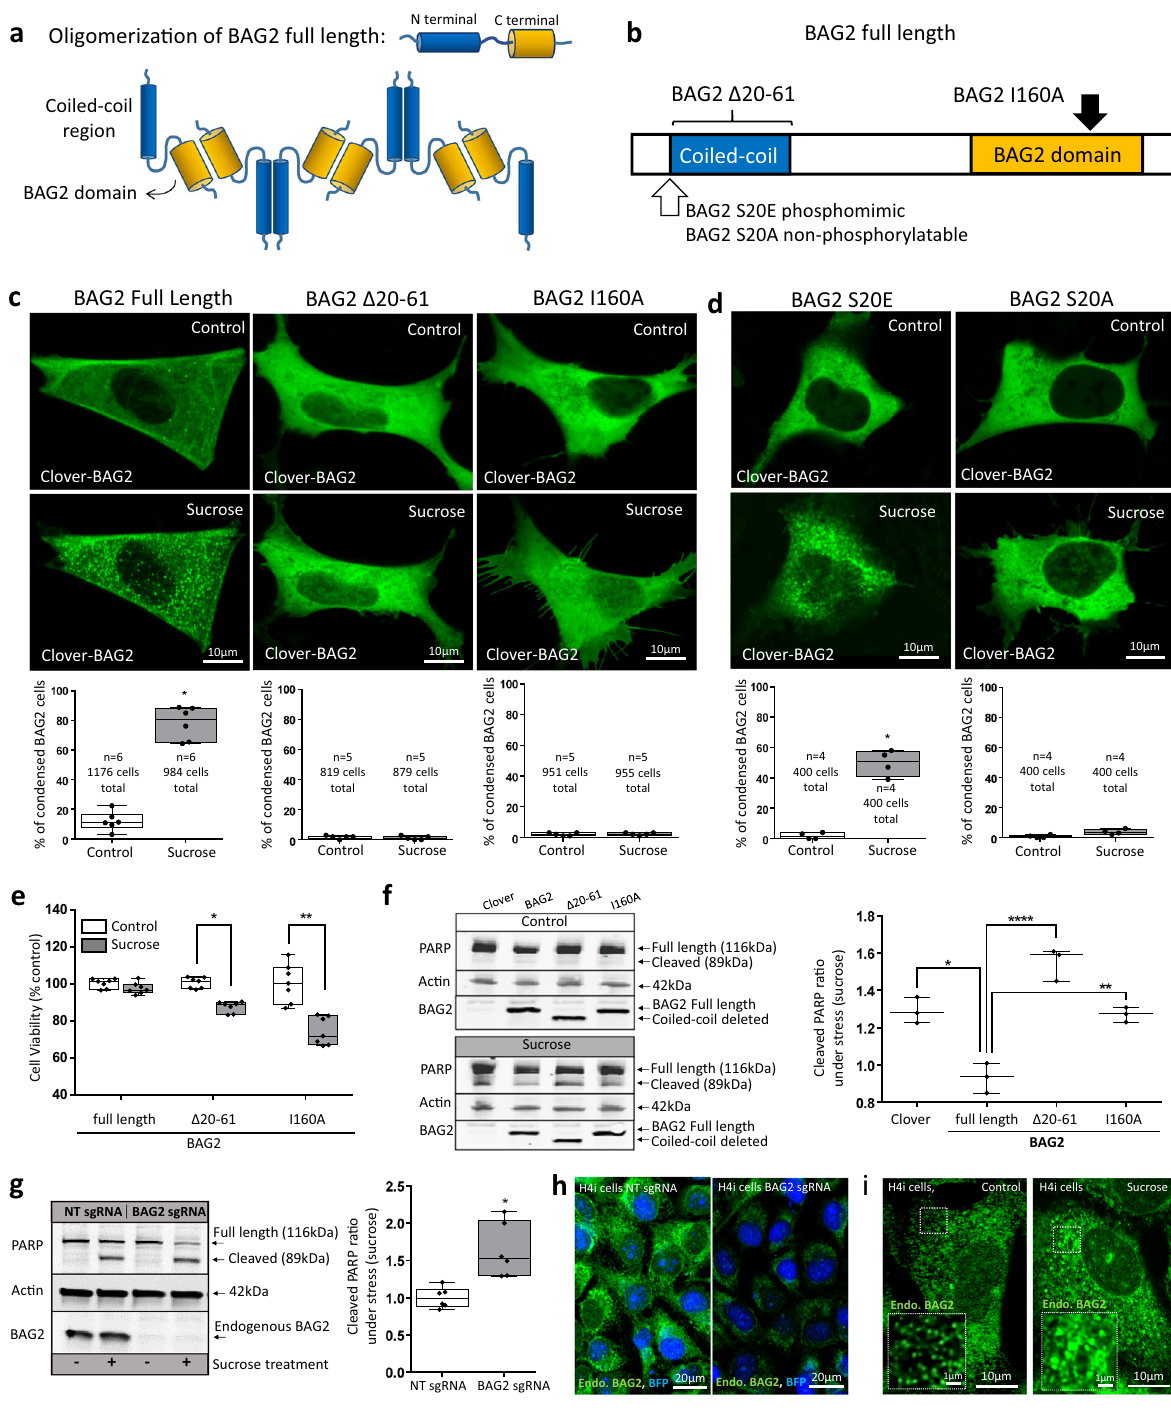
cleaved PARP was increased 66.7 ± 9.4% in BAG2- Δ 20-61 cells ( p = 2.6 × 10 − 5 ) and increased 36.6 ± 4.2% in BAG2-I160A cells ( p = 1.8 × 10 − 3 ) as compared to wild type BAG2 cells (Fig. 3f). Similar results were also observed in cells stably expressing BAG2- Δ 20-61 and BAG2-I160A followed by hyperosmotic stress and probed by PARP antibody (Supplementary Fig. 4b).